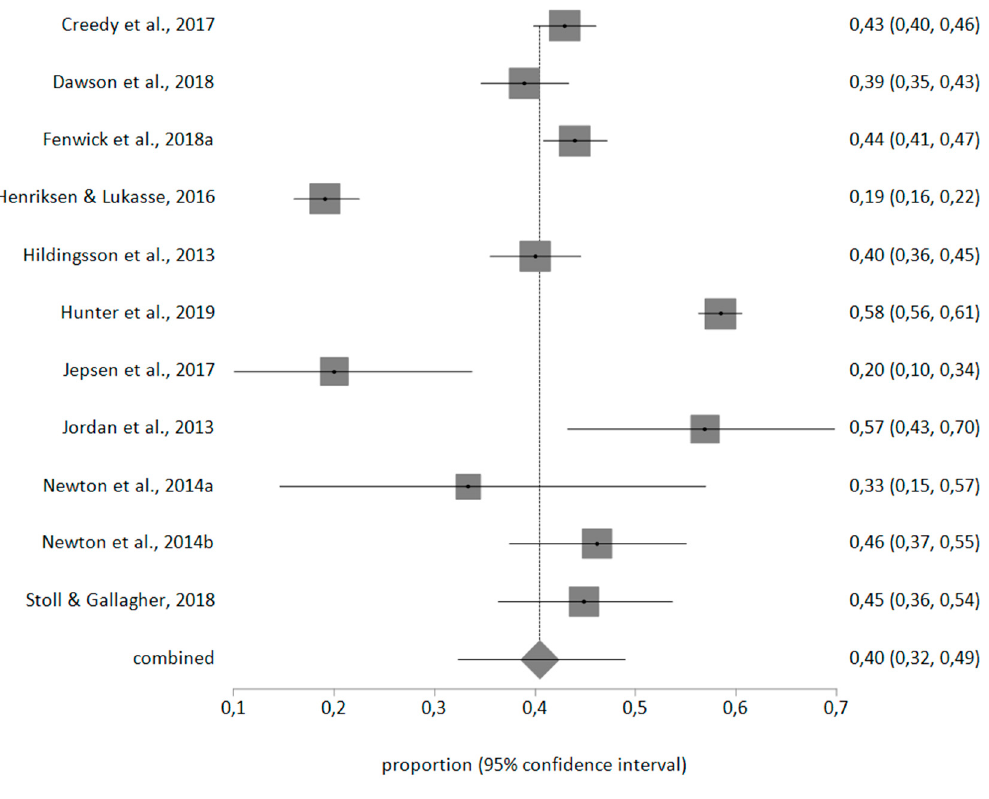
Figure 3. Forest plot of work-related burnout prevalence.